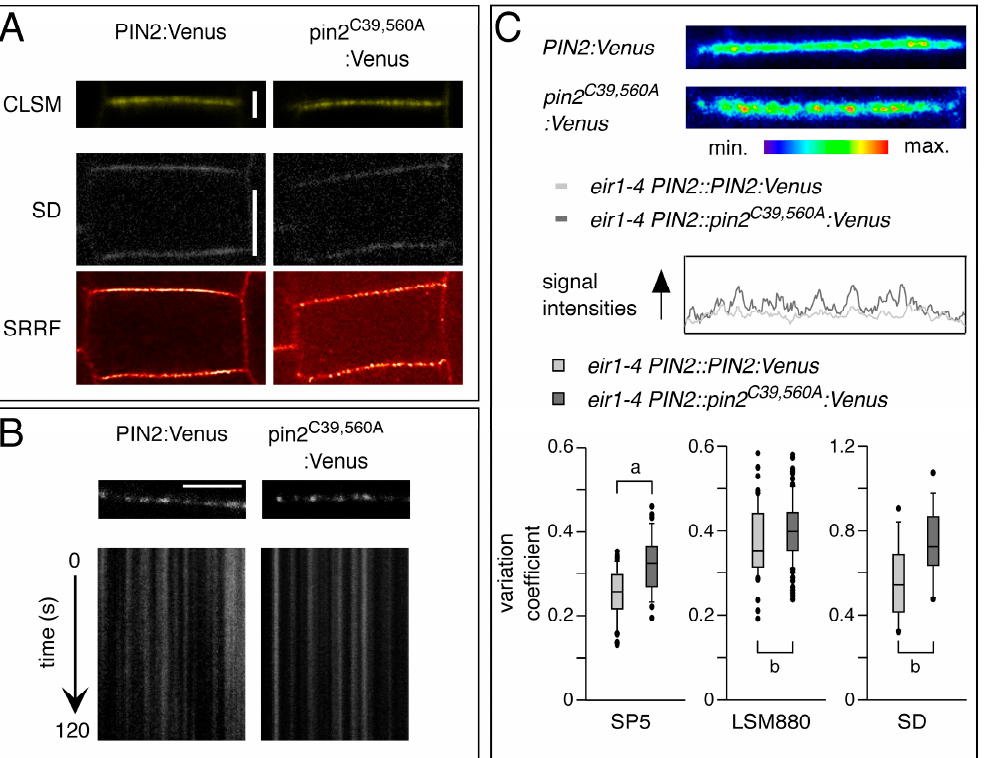
Figure 8. Distribution and mobility of PIN2-Venus reporter proteins. ( A ) Upper row: Comparison of PIN2:Venus ( left ) and pin2 C39,560A :Venus ( right ) signals at the plasma membrane of root epidermis cells, viewed by conventional CLSM imaging. Middle row: A single frame generated by fast SD scanning (50 ms exposition), displaying PIN2:Venus ( left ) and pin2 C39,560A :Venus ( right ) signals at the plasma membrane of root epidermis cells. Bottom row: SRRF algorithm applied to 100 frames generated by SD on the same sections as above. Scale bars 2 μ m (CLSM) and 5 μ m (SD); ( B ) Kymographs representing the fluorescence of PIN2:Venus (left) and pin2 C39,560A :Venus (right) signals over time. Scale bar 5 μ m; ( C ) Top panel: Comparison of signal distribution in root epidermis plasma membrane domains of PIN2:Venus and pin2 C39,560A :Venus. Bottom panels: Box plots displaying PIN2:Venus and pin2 C39,560A :Venus signal intensity profiles at the plasma membrane calculated from CLSM (Leica SP5, Zeiss LSM880) and SD images. Ninety membranes from images generated by Leica SP5, 150 from Zeiss LSM880 and 40 membranes from SD images were used for these analyses. Two-tailed t -test analysis of resulting values demonstrated significant differences ( p < 0.001, “a”; p < 0.05, “b”).